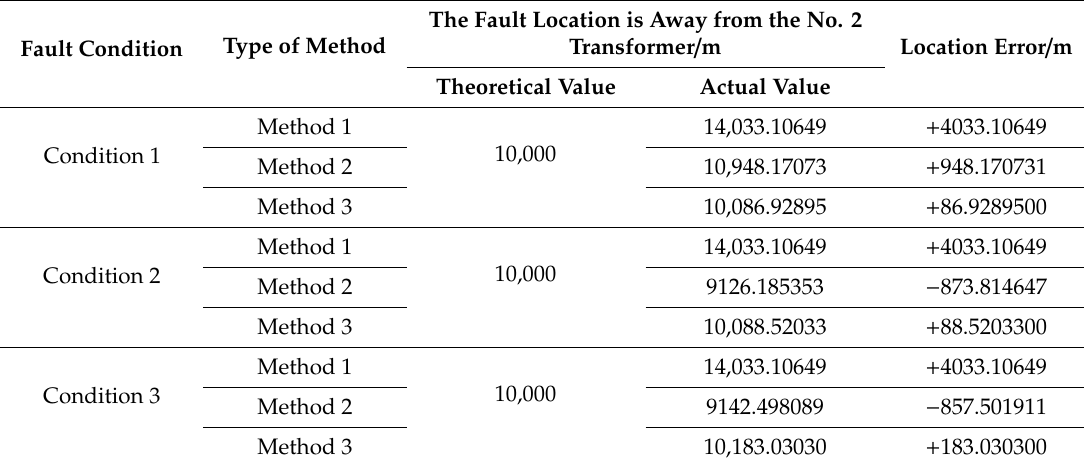
Table 3. Accuracy of three methods in di ff erent